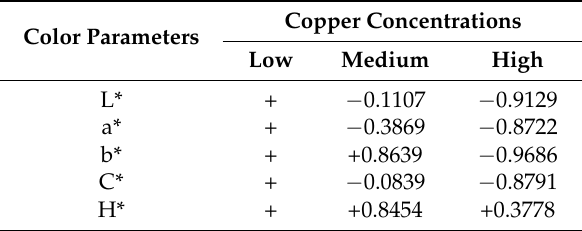
Table 3. Lineal correlation coefficients (R 2 ) between copper concentrations and color of wine. Color